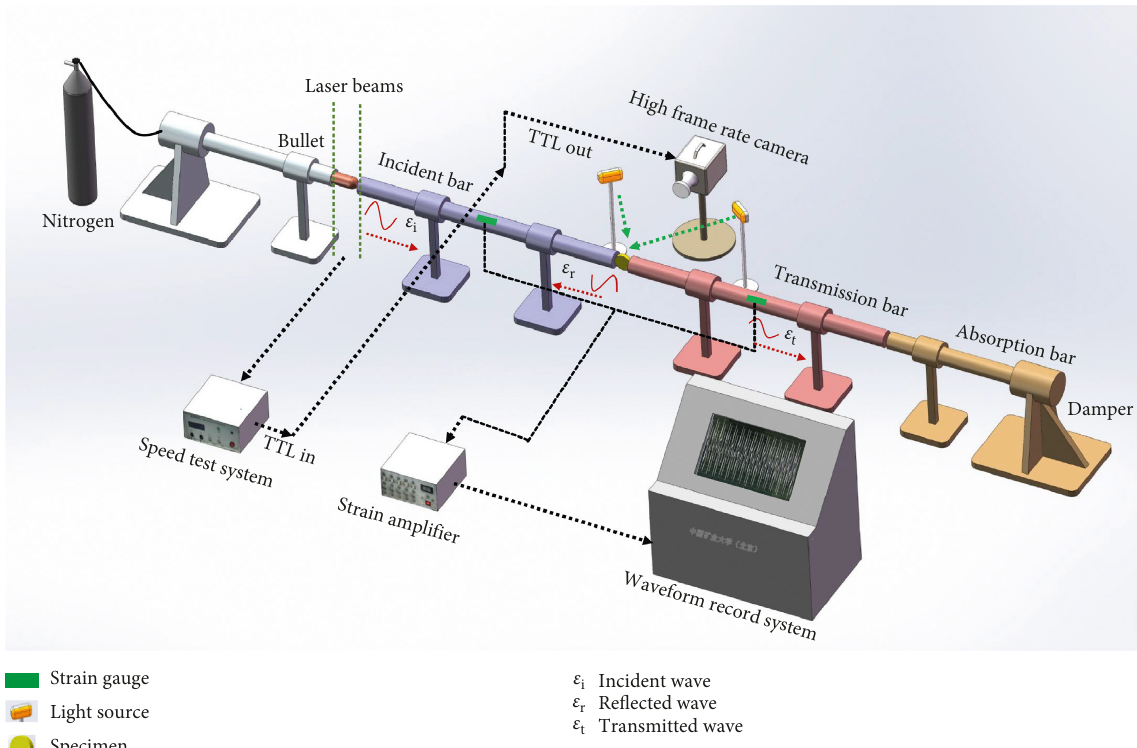
Figure 1: Schematic map of the SHPB experimental system.